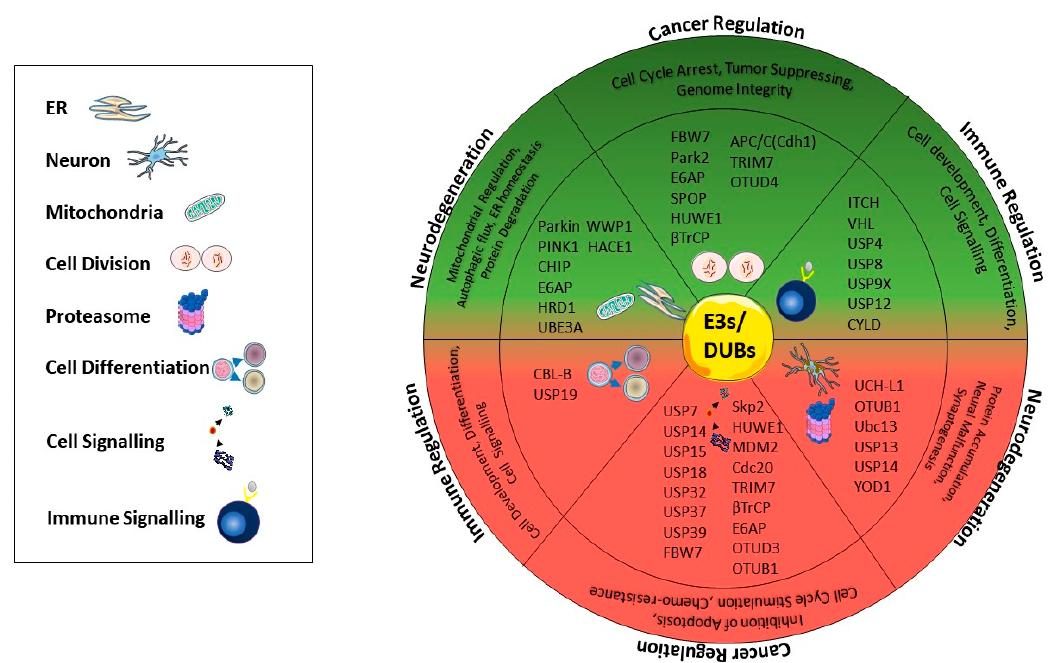
Figure 3. Summary of DUBs and E3 enzymes that play important roles in cancer progression, immune regulation, and neurodegenerative diseases. According to diseases, the enzymes positively or negatively regulate the mechanisms in mitophagy, cell differentiation, cell development, signaling, protein accumulation, neural malfunction, synaptogenesis, inhibition of apoptosis, cell cycle stimulation, mitochondrial regulation, autophagic flux, ER homeostasis, and protein degradation. E3 ligases and DUBs in the upside or downside of the semicircle indicate negative (red area) or positive regulators (green area) of these diseases.